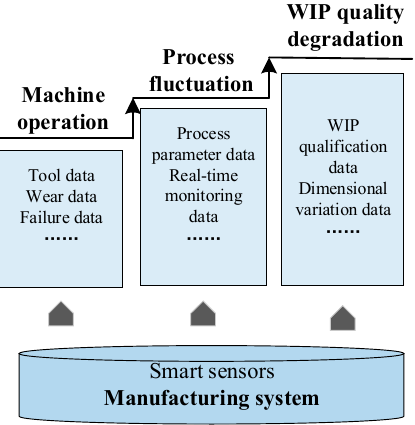
Figure 4. Collection of operational characteristics data from sensors.